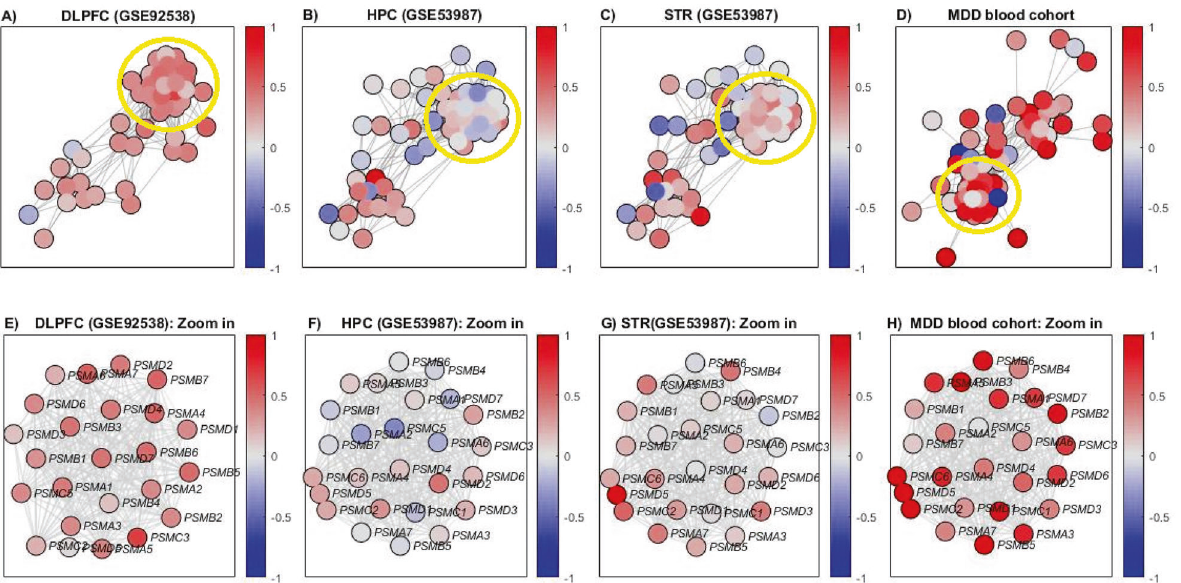
Fig. 3 Pathway-based differential expression analysis of the ubiquitin-proteasome dependent proteolysis superpathway. A Differential expression of the ubiquitin-proteasome-dependent proteolysis superpathway measured on dorsolateral prefrontal cortex (DLPFC) (GSE92538) data. The colors of the nodes represent the deviation in expression of the MDD samples from the healthy control group; the edges represent relations of co-expression of the STRING database (see Supplementary Methods section 7). Only genes with relation to at least one other gene in the superpathway are displayed. The yellow circle represents a subgroup of highly interconnected proteasome subunit genes. B The same as in A) for the hippocampal (HPC) (GSE53987) data. C The same as in A) for the striatal (STR) (GSE53987) data. D The same as in ( A ) for the MDD PBMC cohort. E Zoom-in on the proteasome subunit genes that are circled in ( A ). F Zoom-in on the proteasome subunit genes that are circled in ( B ). G Zoom-in on the proteasome subunit genes that are circled in ( C ). H Zoom-in on the proteasome subunit genes that are circled in ( D ). Note that there is a blue-colored gene in ( D ) which is circled, UBE2V2, which does not appear in ( H ) as it does not encode a proteasome